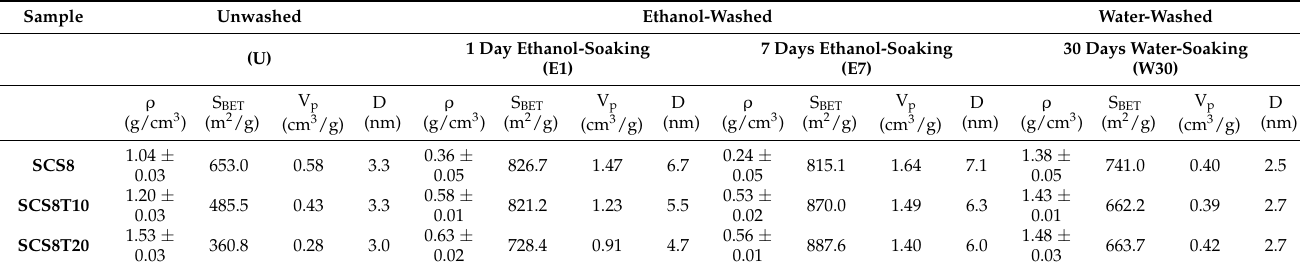
Table 2. Bulk density and textural data of SiO 2 /CS/TCP xerogels subjected to different washing treatments (U, E1, E7, and W30) before